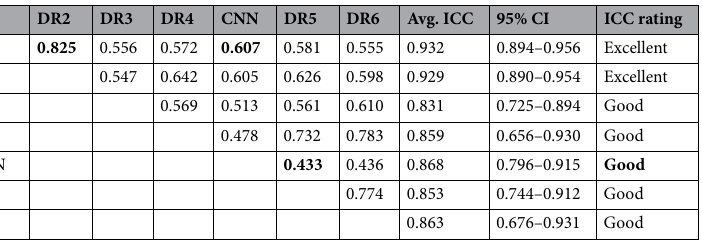
Table 3. A summary of weighted k values and ICC Weighted kappa values less than 0.20 indicate poor agreement, 0.21 to 0.40 indicate fair agreement, 0.41 to 0.60 indicate moderate agreement, 0.61 to 0.80 indicate good agreement, and greater than 0.80 indicate very good agreement. ICC below 0.5 is considered poor reliability, 0.5 and 0.75 as moderate reliability, 0.75–0.9 as good reliability, and over 0.90 as excellent reliability 31,32 . Significant values are in bold.